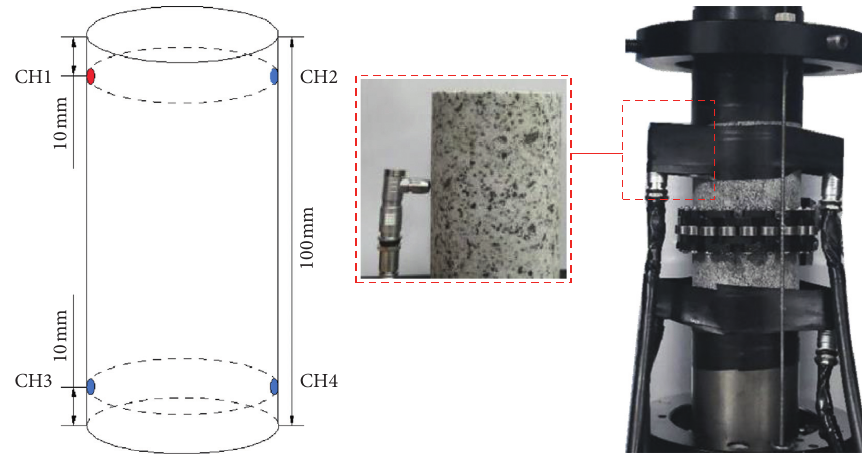
Figure 4: Arrangement scheme of the dry-coupled ultrasonic